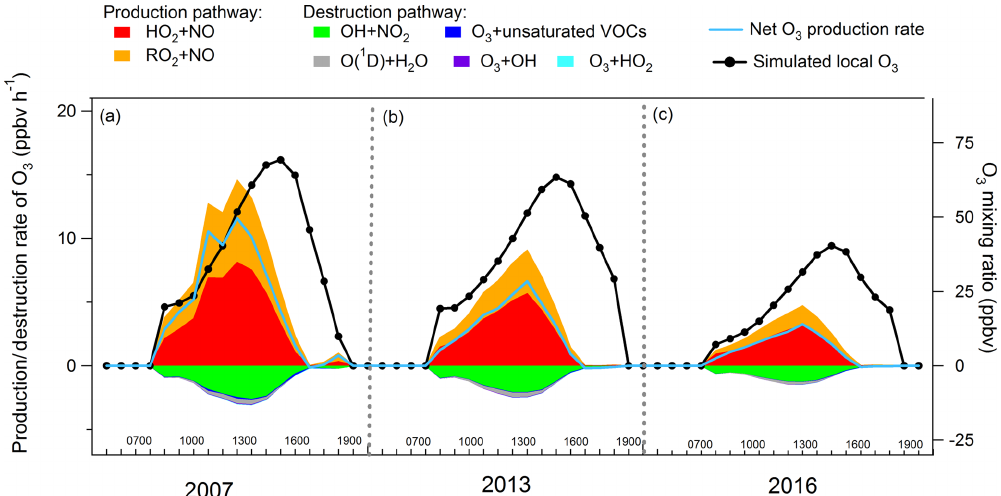
Figure 6. Average diurnal profiles of the local O 3 production and destruction rates in the sampling campaigns of (a) 2007, (b) 2013 and (c)